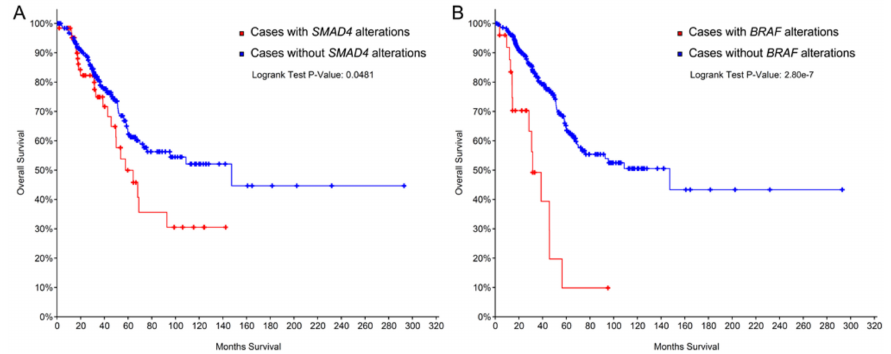
Figure 4. Overall survival of 312 colorectal cancer patients with liver metastases based on SMAD4 ( A ) and BRAF ( B ) gene alterations. Survival curves are built according to the Kaplan–Meier method. Data from The Cancer Genome Atlas Network are publicly available at